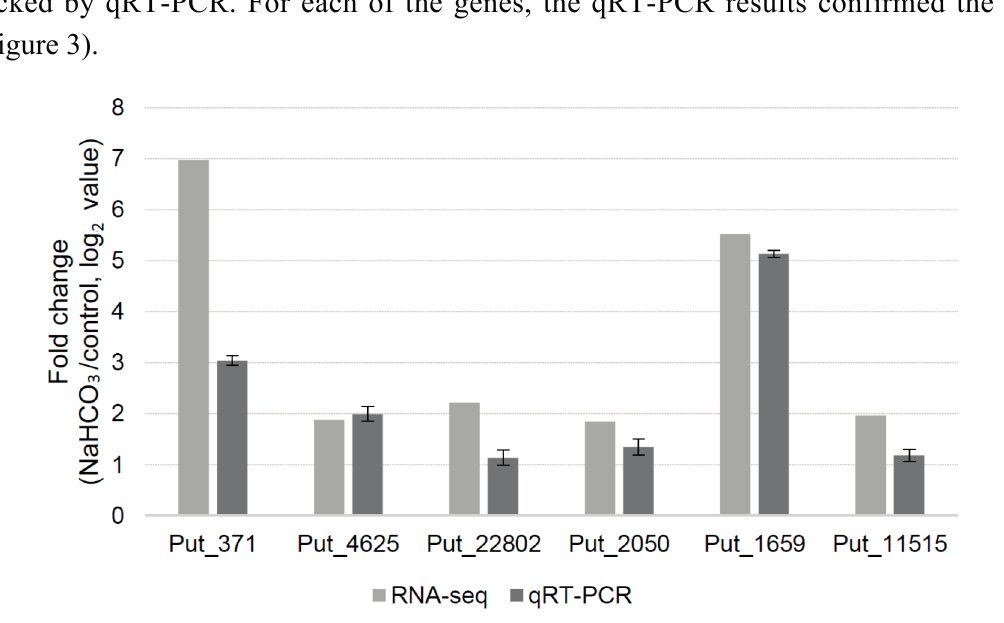
Figure 3. Fold change in expression values (expressed as Log 2 values) of selected genes as determined by RNA-seq analysis and real-time quantitative RT-PCR. RNAs extracted from the same plant samples were used for the two analyses and tubulin was used as an internal control for the